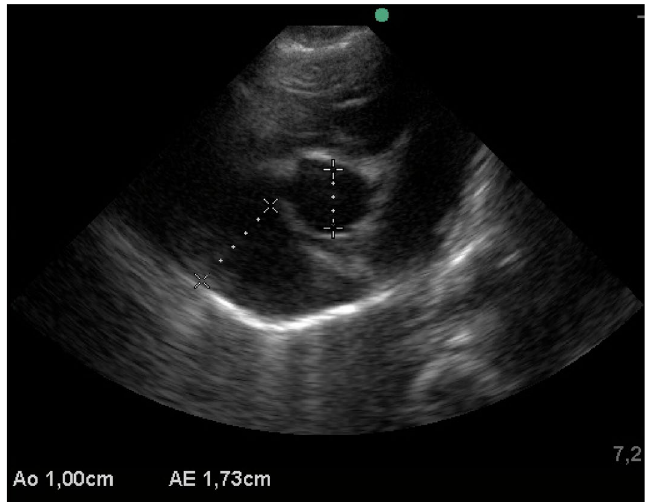
Figure 4. Echocardiographic evaluation, two-dimensional mode, and left atrium/aorta